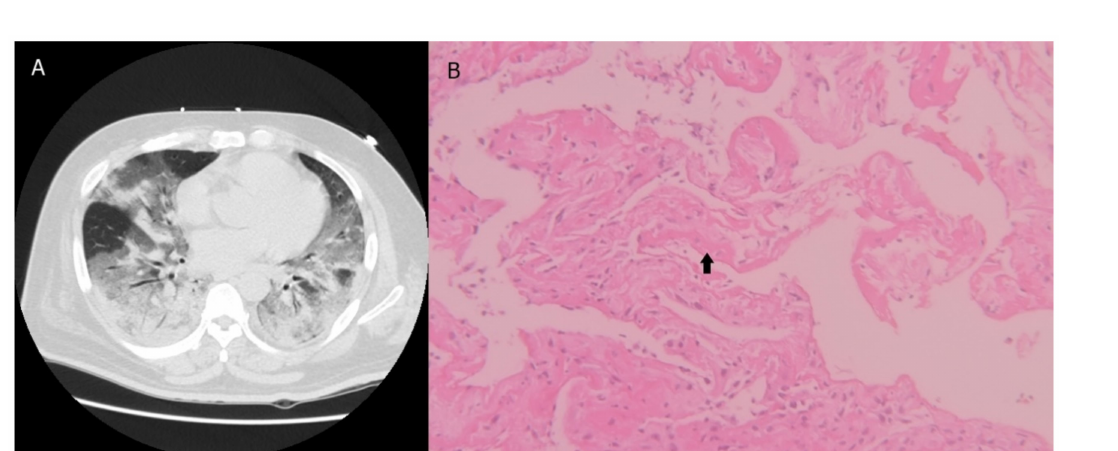
Figure 1. ( A ) The transverse unenhanced chest CT image showed dependent and peribronchovascular consolidations as well as diffuse heterogeneous ground glass opacities in bilateral lungs. ( B ) The pathology result showed diffuse alveolar damage patterns. The alveolar walls were thickened by organizing loose connective tissue. Hyaline membranes were seen (arrow) (hematoxylin and eosin stain, 200 ×